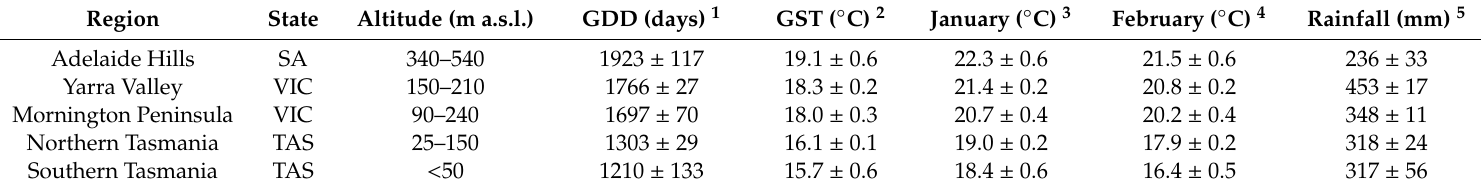
Table 2. Altitude, and means ( ± SD) of climatic data for the viticultural sites ( n = 3 per region) from 1 October 2017 to 30 April 2018 (i.e., growing season in the Southern